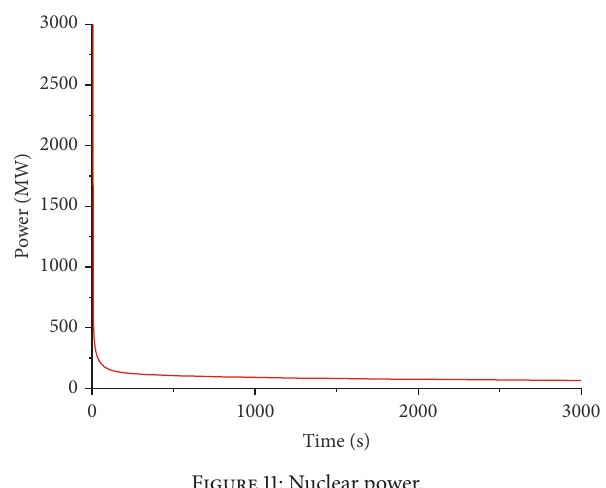
Figure 12: Liquid break discharge flow rate.